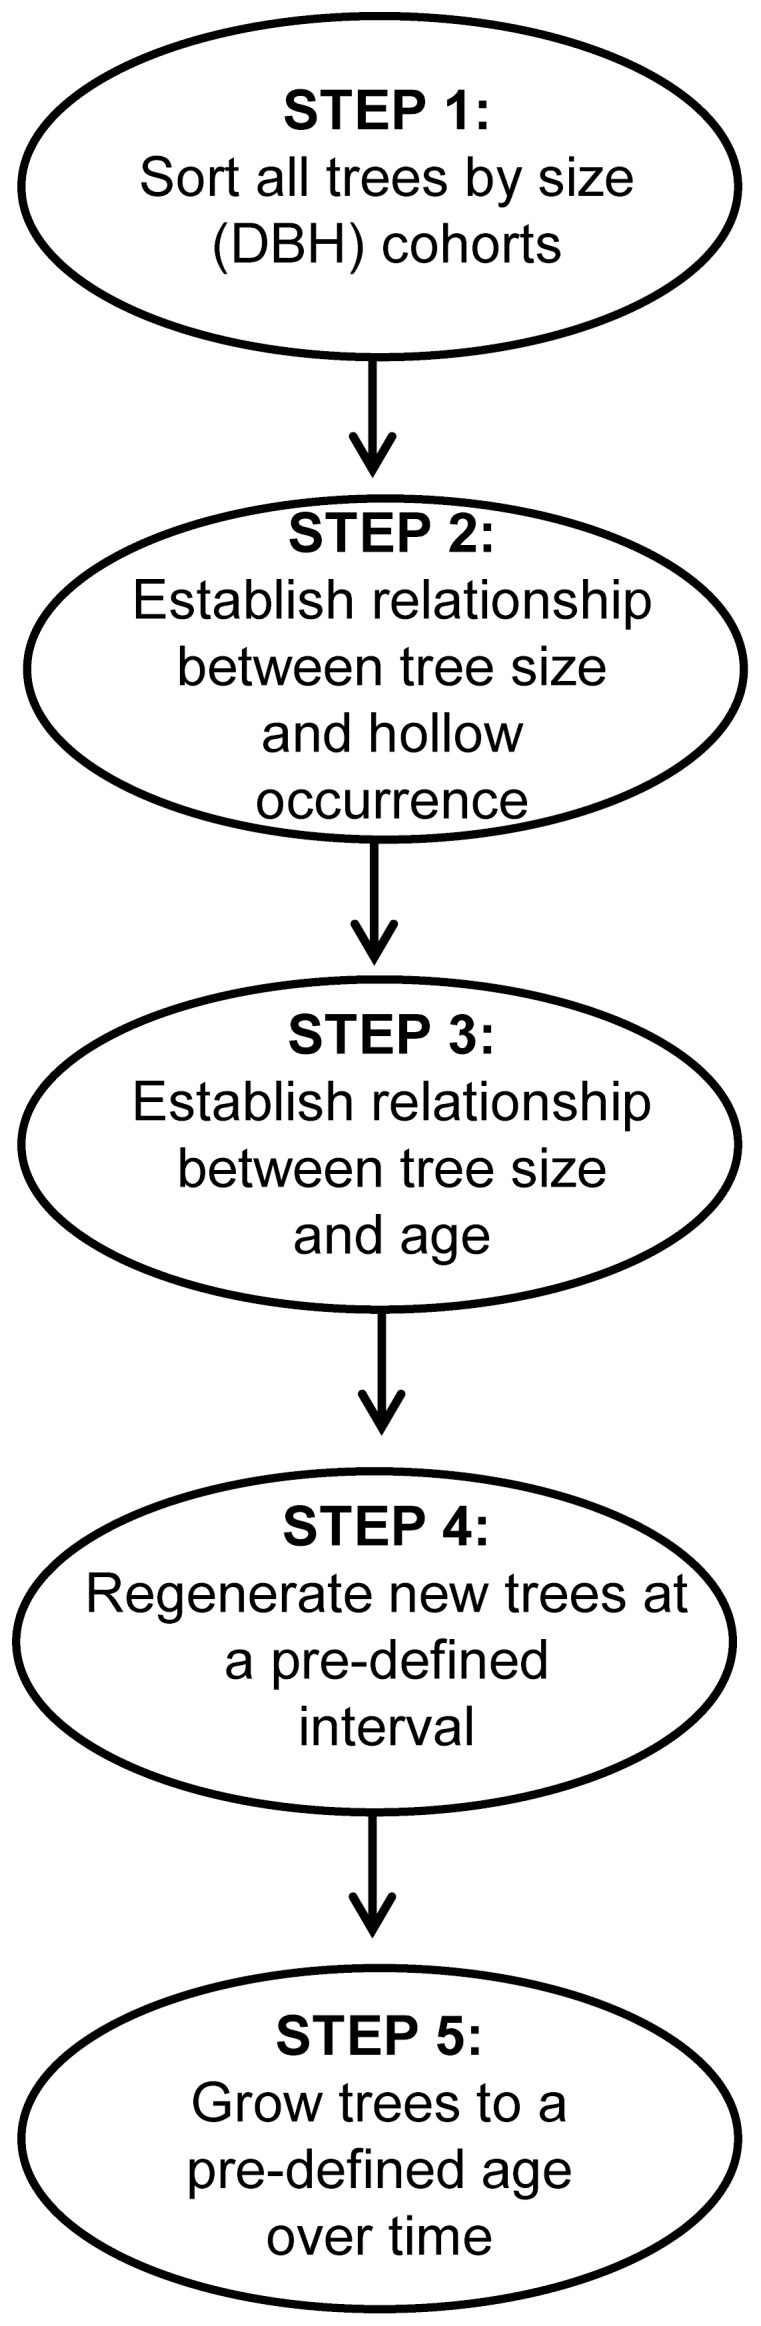
Simple schematic highlighting the five principle steps of our simulation model.